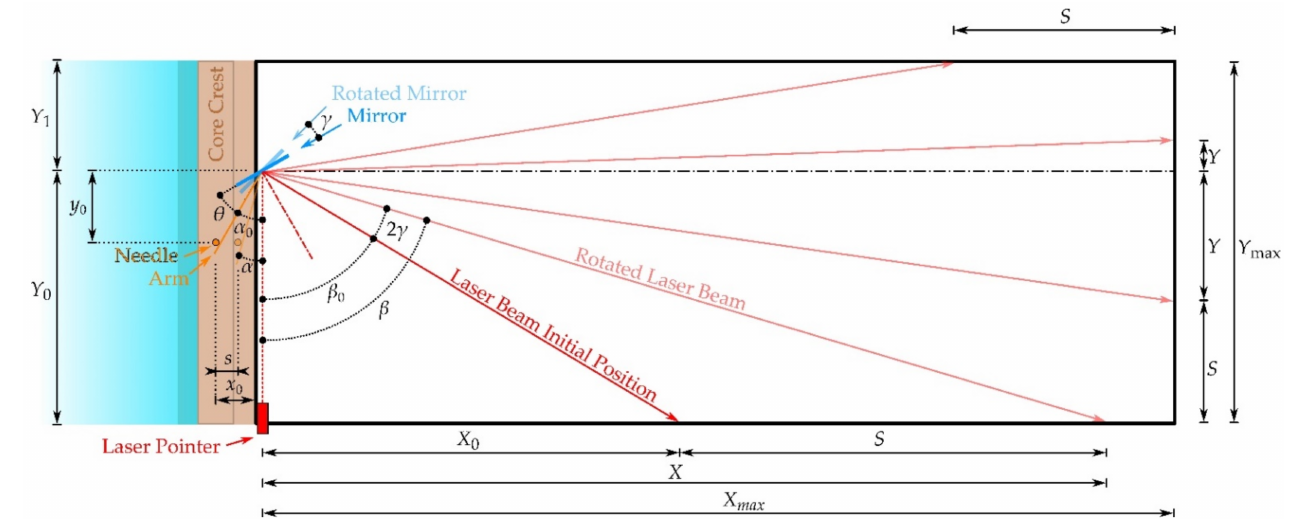
Figure 6. Top view scheme of the measuring system designed to control the displacements of the cohesive core. The dimensions of the elements of this system are not scaled to their true